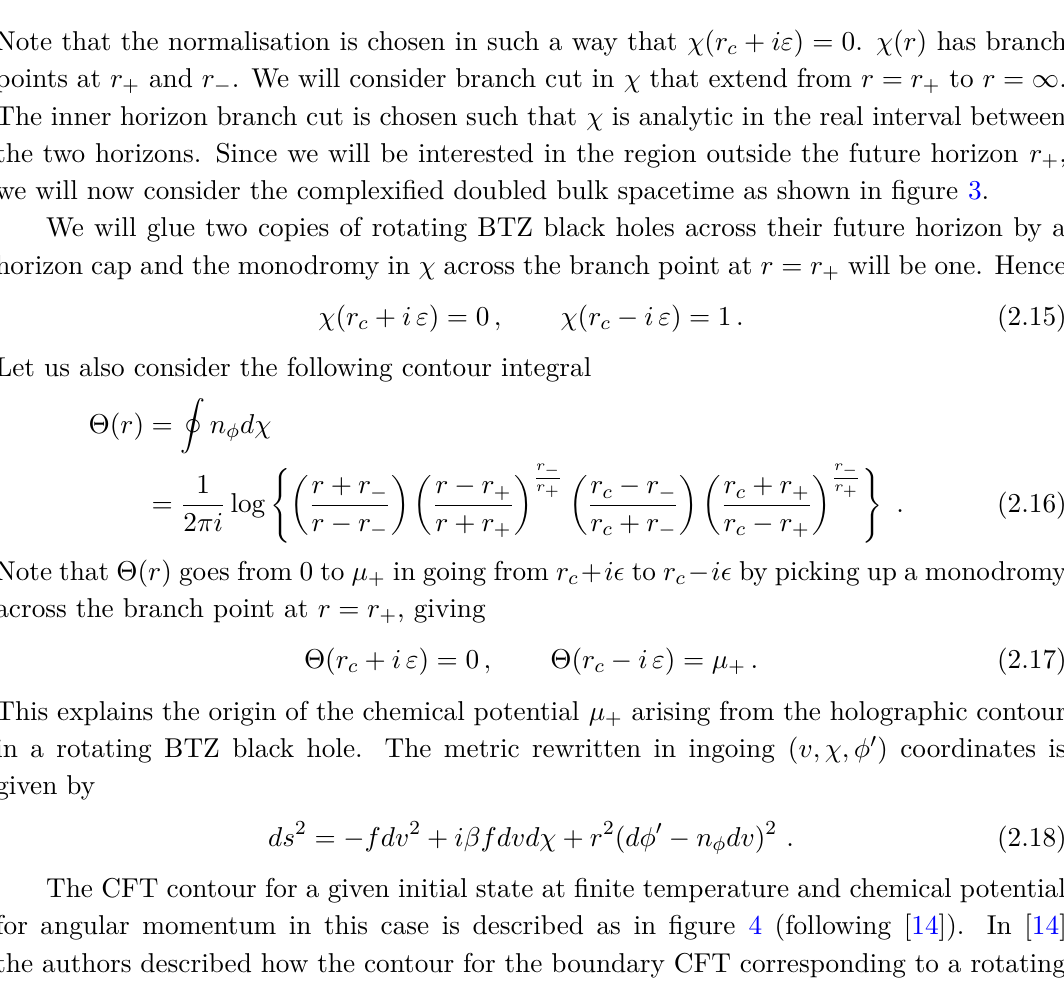
Figure 3 . Picture of bulk at a fixed v : red line is branch cut from horizon to